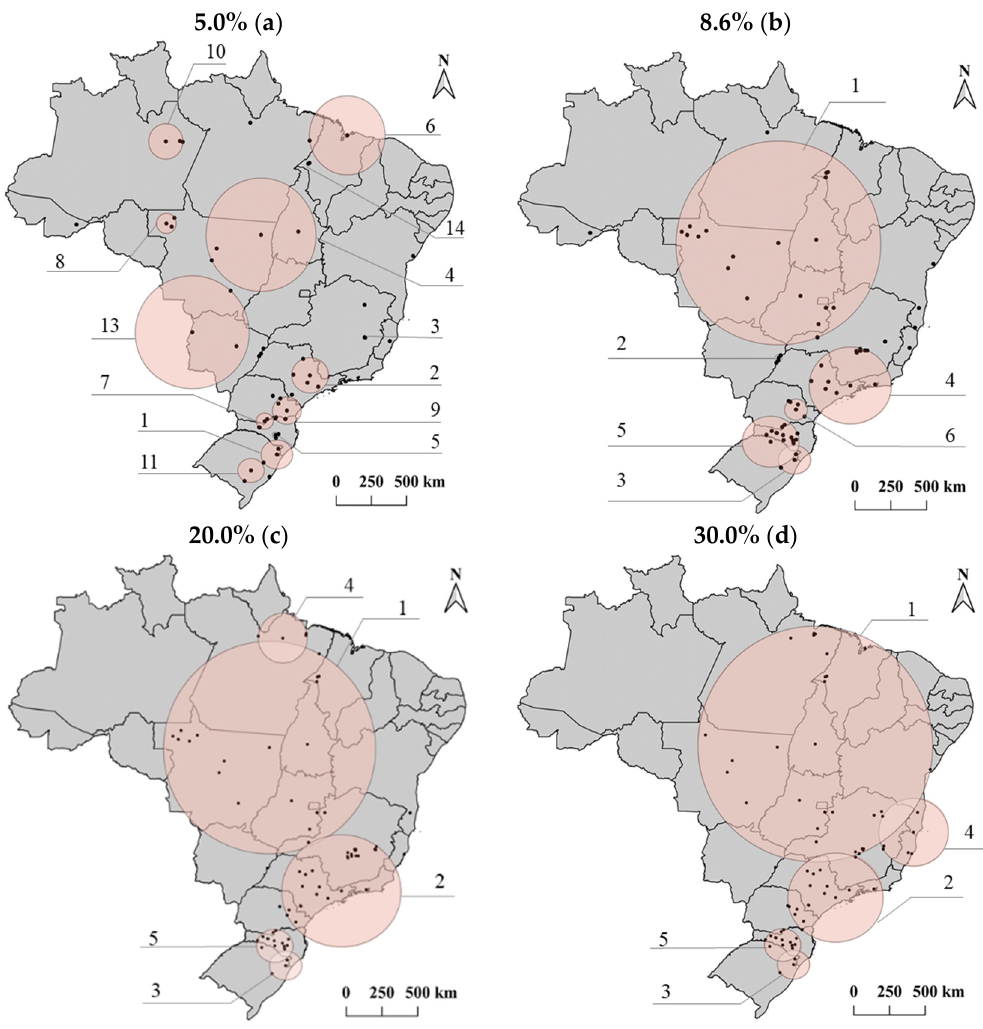
Figure 2. Forest-based power plants clusters in Brazil for regarding the probability of 5.0%, 8.6%, 20.0%, and 30.0% probability of that the electricity generation being is forest-based, from 2000 to